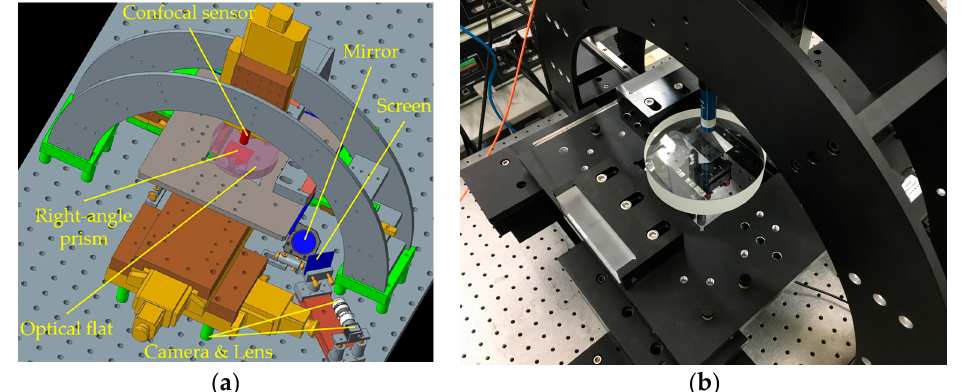
Figure 19. System configuration: ( a ) 3D design; ( b ) actual setup.